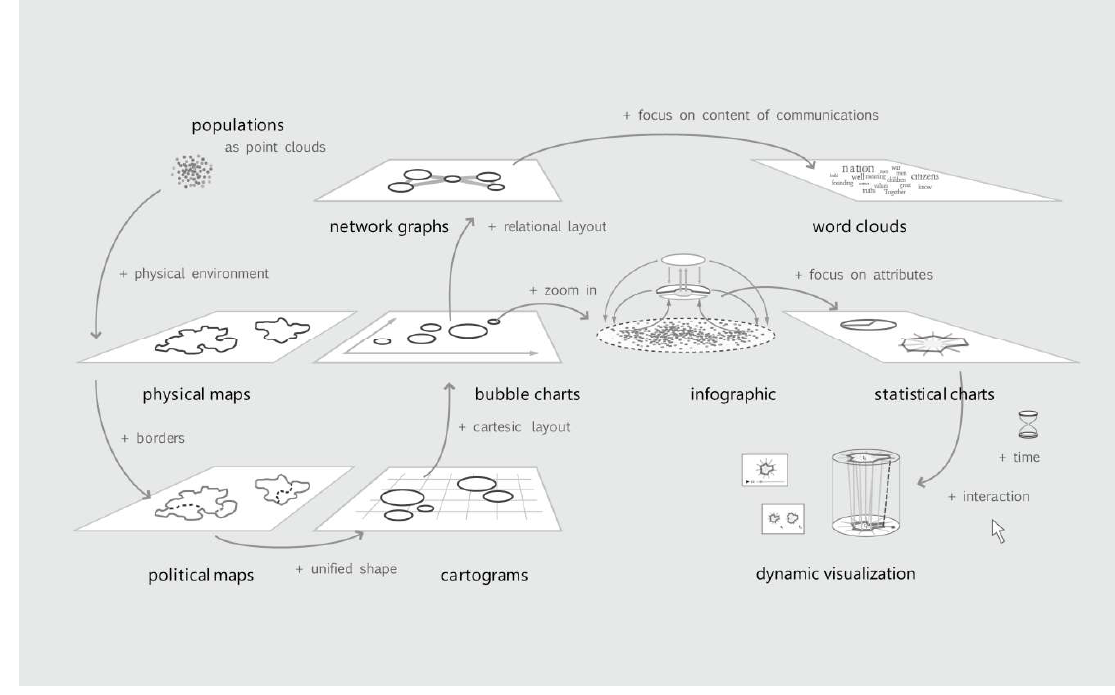
Figure 8: A synoptic perspective on the presented visualization methods, using arrows to show some of the possible conceptual connections and visual-analytical transitions between